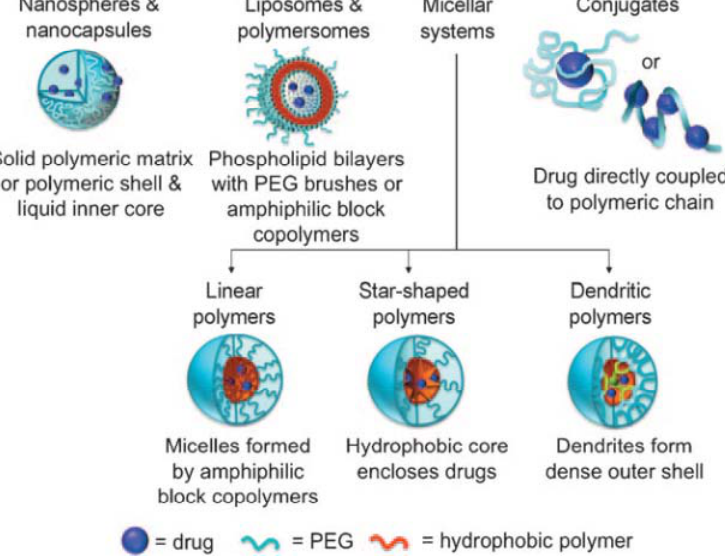
Figure 1. Overview of carrier systems for drug delivery systems (Adapted from